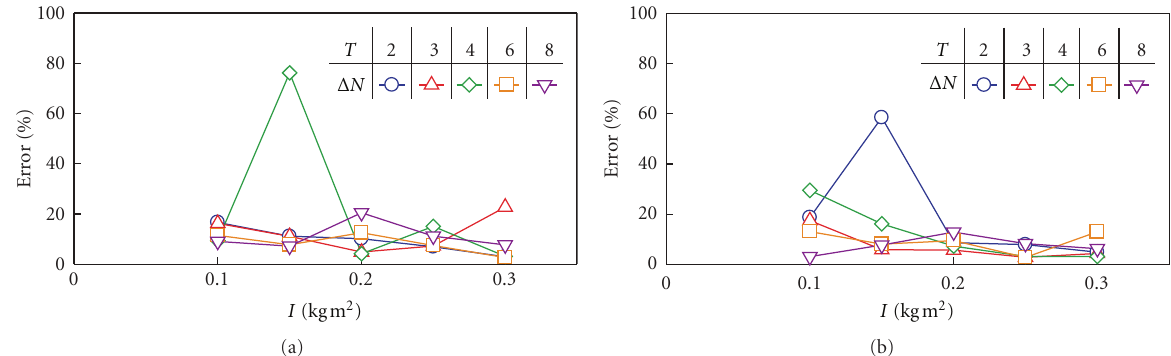
Figure 8: Experimental error of rotational speed width for wind amplitude (a) Δ V = 1 and (b) Δ V =